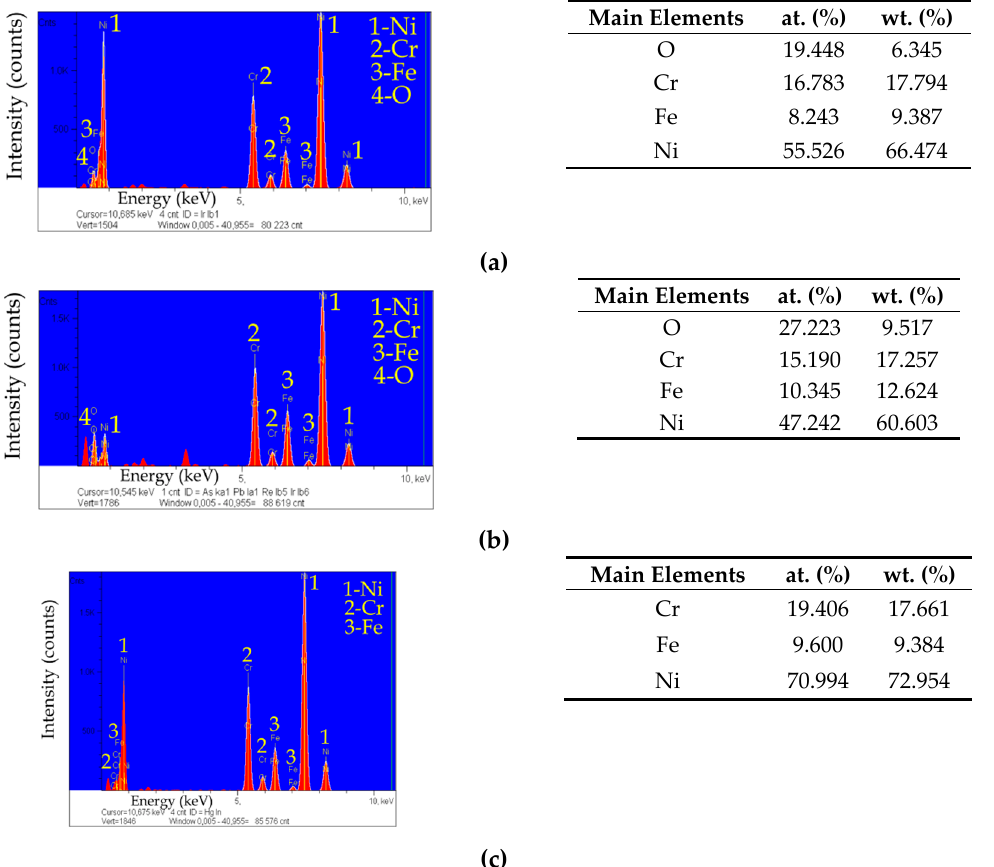
Figure 19. Chemical composition of the surface around the top diameter as determined by EDS: ( a ) zone of cavities, ( b ) darker zones near the cavities, ( c ) brighter zones between the cavities.